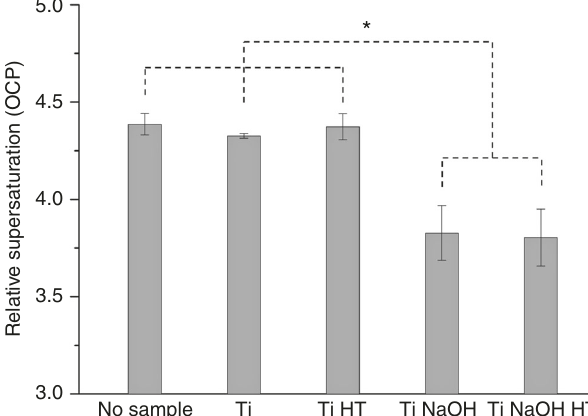
Fig. 4 Solution relative supersaturation toward OCP at the fi rst nucleation onset in different titration experiments. The relative supersaturation σ is calculated using the ratio of the activity product of ion units composing the crystal to the corresponding solubility product K sp considering the number of ion units (details in Supplementary Note 1 36 ). Adsorption of free Ca ion by Ti NaOH and Ti NaOH HT is taken into account in the calculation, which slightly lowers the Ca concentration. pH changes due to the addition of powders are found to be negligible (<0.01) and thus not taken into account. Statistically signi fi cant differences between groups are marked with a (*) with p value smaller than 0.01. The error bars are calculated standard